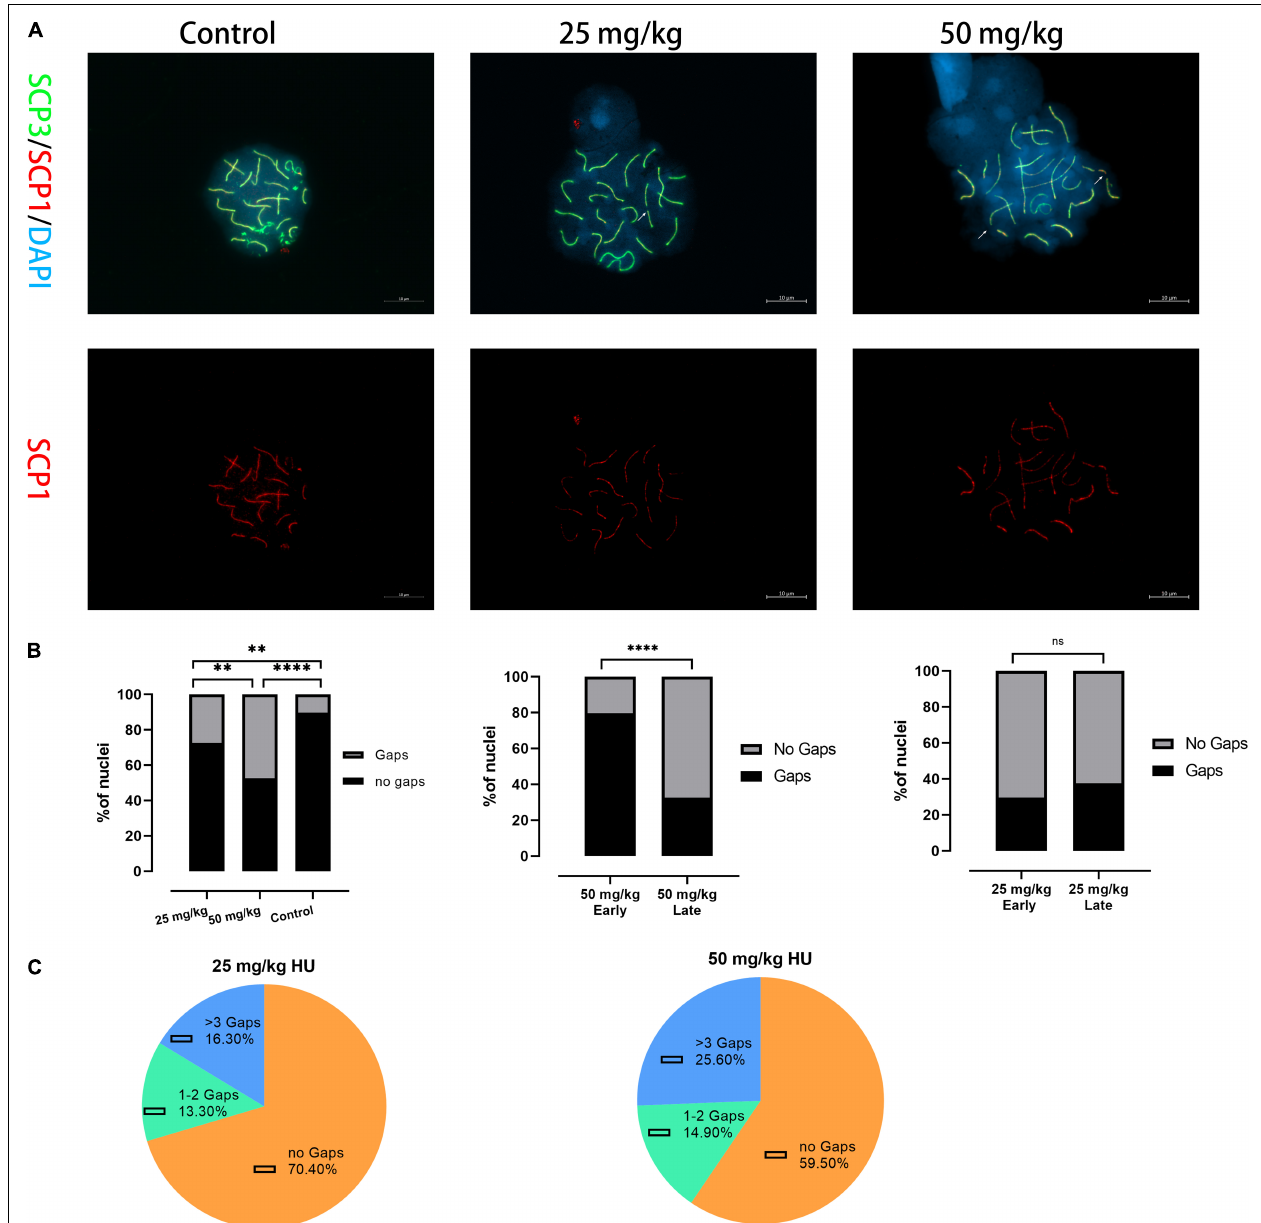
FIGURE 2 | Alterations in the synapsis process in HU-exposed male mice. (A) Pachytene spermatocyte chromosome spreads were immunostained with antibody SCP3 (green) and SCP1 (red) in controls and mice injected with 25 and 50 mg/kg of HU. Of note, mice injected with 25 and 50 mg/kg of HU show synaptic abnormalities. Arrows indicate example gaps (i.e., SC discontinuities). Scale bars = 10 µ m. (B) Quantification of the proportions of SC gaps in pachytene nuclei after HU injection; mice injected with 29.5% of 25 mg/kg and 40.4% of 50 mg/kg of HU, compared with 11.5% of controls pachytene nuclei ( n = 100; using the